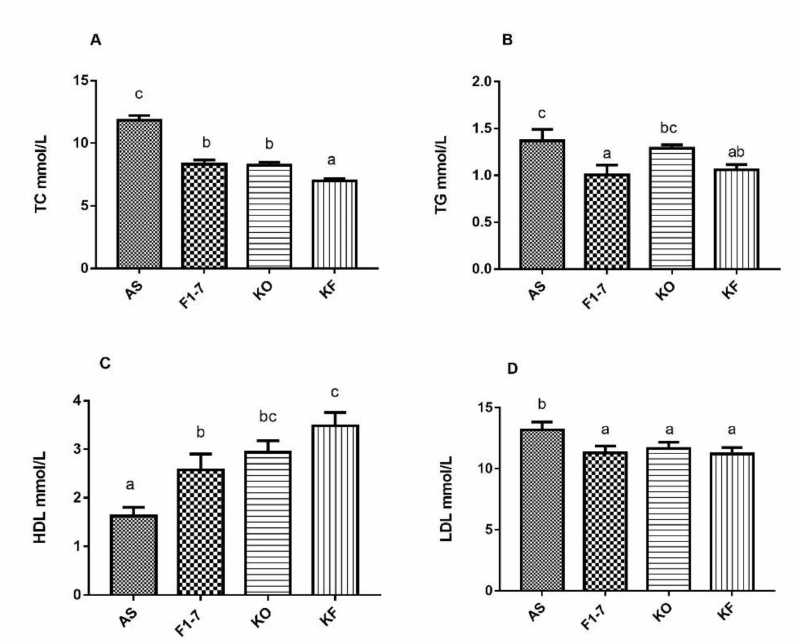
Figure 3. Influence of KO and the mixture of KO and Bif. animalis F1-7 on serum lipids (n = 6). ( A ) TC, ( B ) TG, ( C ) HDL, and ( D ) LDL. Different letters indicate significant differences from each group, p <